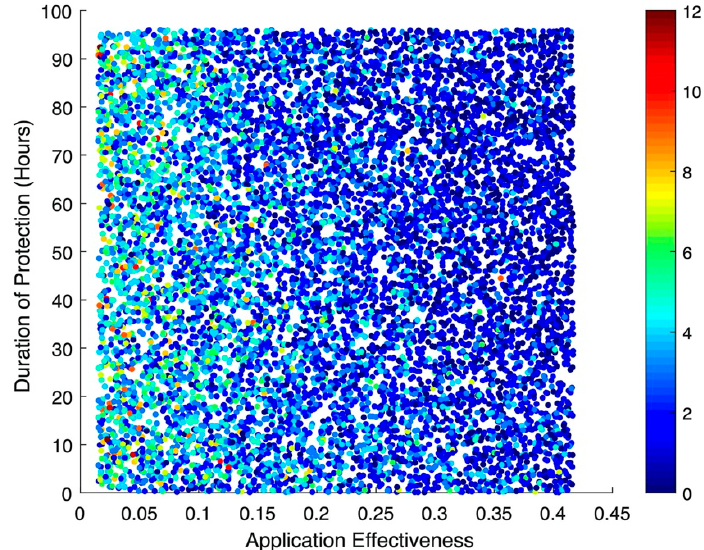
Figure 4. Scatterplot of incident MRSA-related bacteremia cases in an 18-bed ICU over a simulated year. Each dot represents one of 10,000 iterations of a stochastic model, simulating a spread of possible levels of effectiveness and duration of protection for a hypothetical long-acting decolonization agent.